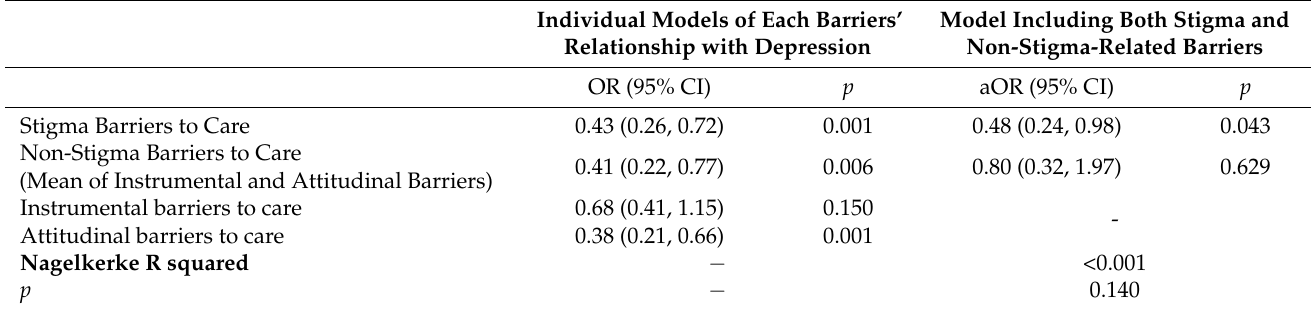
Table 5. Logistic Regression Associating Barriers to Accessing Mental Health Care with Wellness, n = 323. Individual Models of Each Barriers’ Relationship with